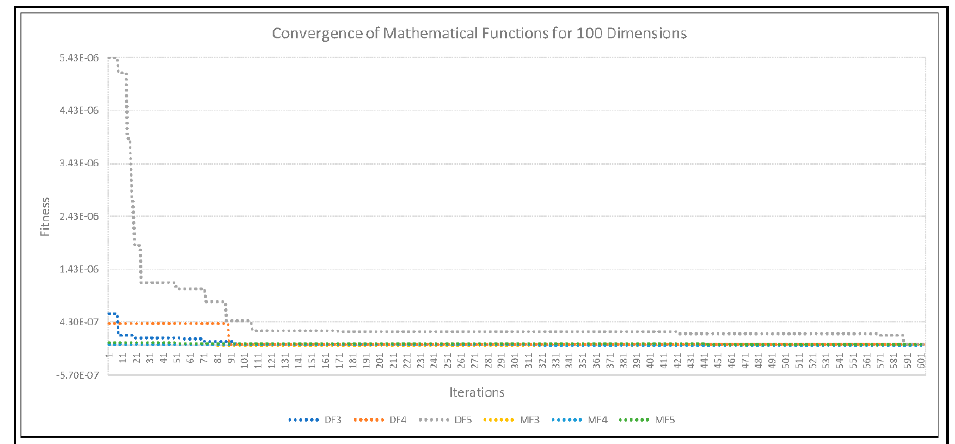
Figure 10. Convergence of the DMOA and MTOA algorithms for 50 dimensions, for the func- tions F2, F3, and F4.